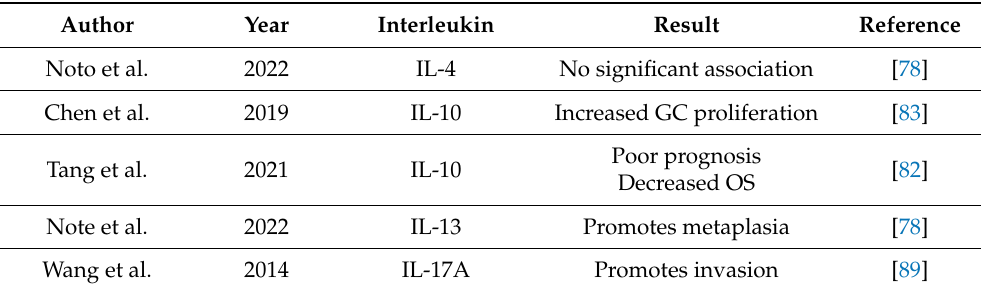
Table 3. The role of interleukins in the development of